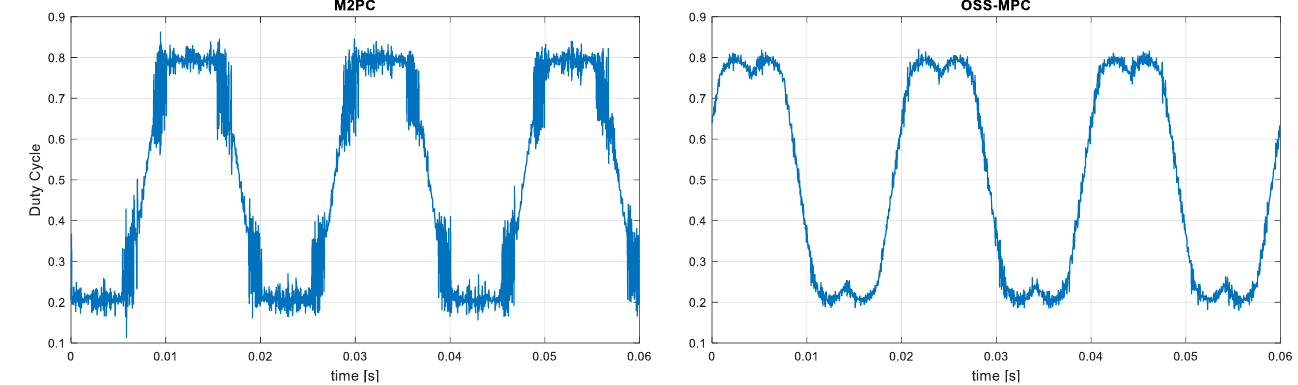
Figure 16. Comparison of phase a SVM sector selection for M2PC and OSS-MPC for 𝑃 ∗ = 4 kW, 𝑄 ∗ = 4 kVAr (obtained from CCS).